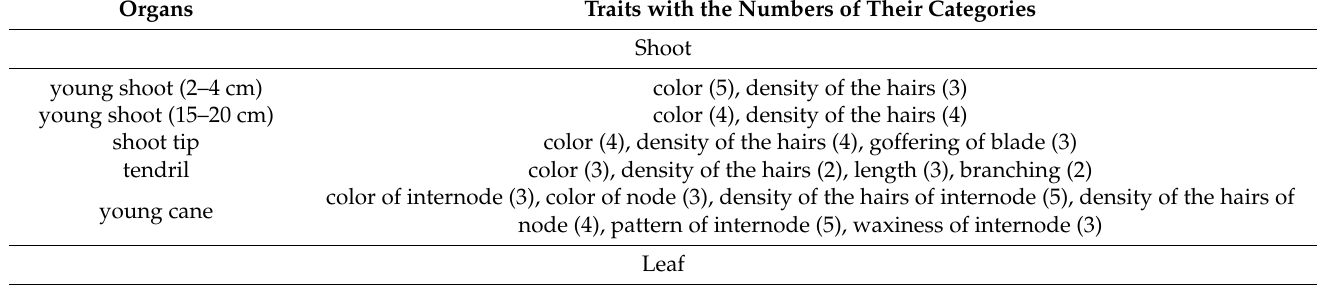
Table 3. The 125 morphological traits of Vitis vinifera L. cultivars, according to N é meth [7] involved in our analysis, where the number of categories is given in